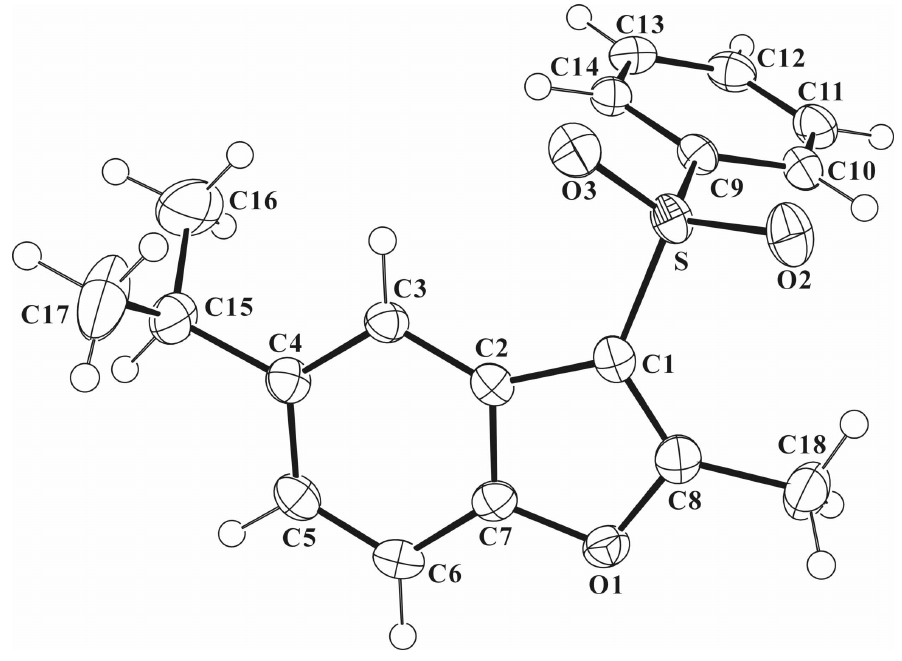
Figure 1 The molecular structure of the title compound, showing displacement ellipsoides drawn at the 50% probability level.